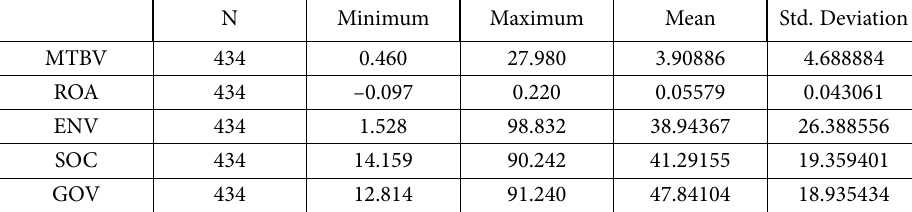
Table 1. Descriptive statistics (global) (source: own construction by using SPSS)